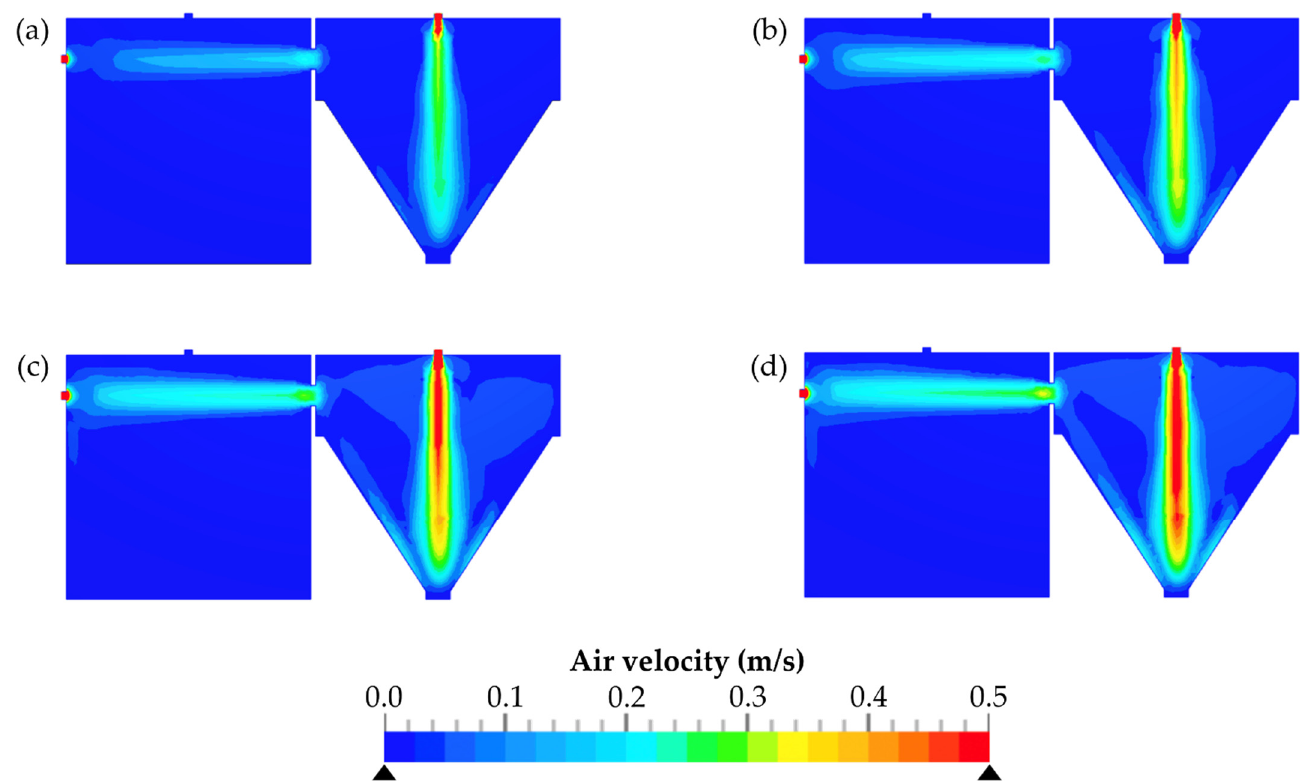
Figure 7. Resulting air velocities depending on the pressure difference between the emission and the detection chamber. Δ p values: 1 Pa ( a ); 2 Pa ( b ); 3 Pa ( c ); 4 Pa ( d ). detection chamber. ∆ p values: 1 Pa ( a ); 2 Pa ( b ); 3 Pa ( c ); 4 Pa ( d ).